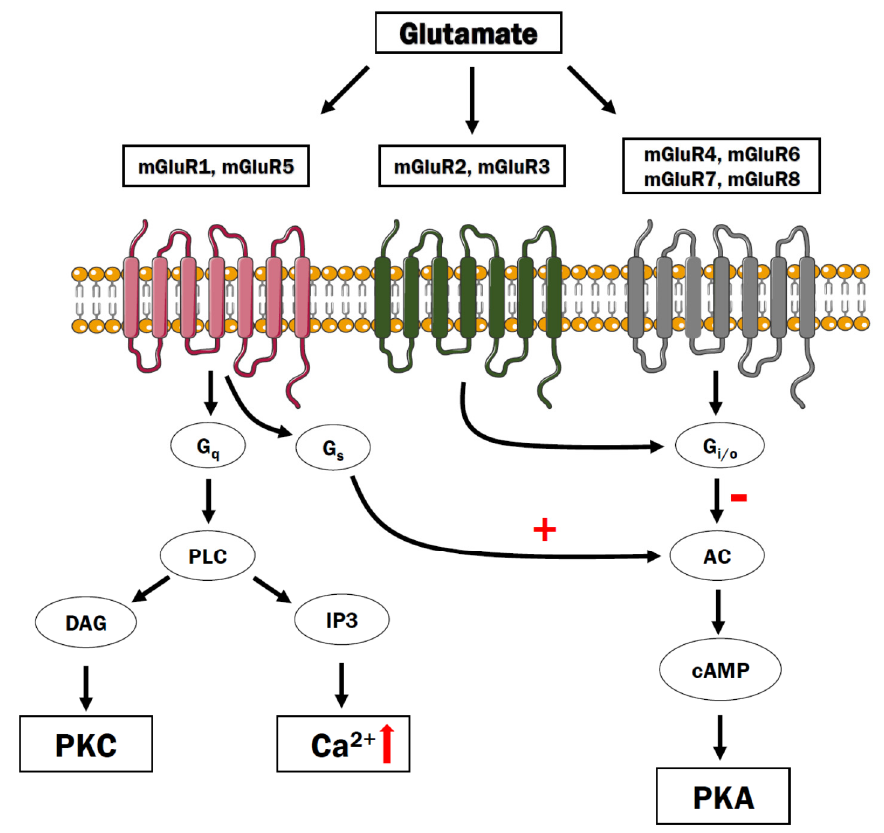
Figure 5. The metabotropic glutamate receptors. The group I mGluRs couples to Gq, which stimulates PLC activity and inositol 1,4,5-triphosphate (IP 3 ) and diacylglycerol (DAG). The IP 3 diffuses to the endoplasmic reticulum and activates the IP 3 receptors to release Ca 2+ to the cytosol. The Group I can also couple to adenylyl cyclase to stimulate cAMP production. By contrast, Groups II and III couple to G i/o proteins and inhibit adenylyl cyclase.